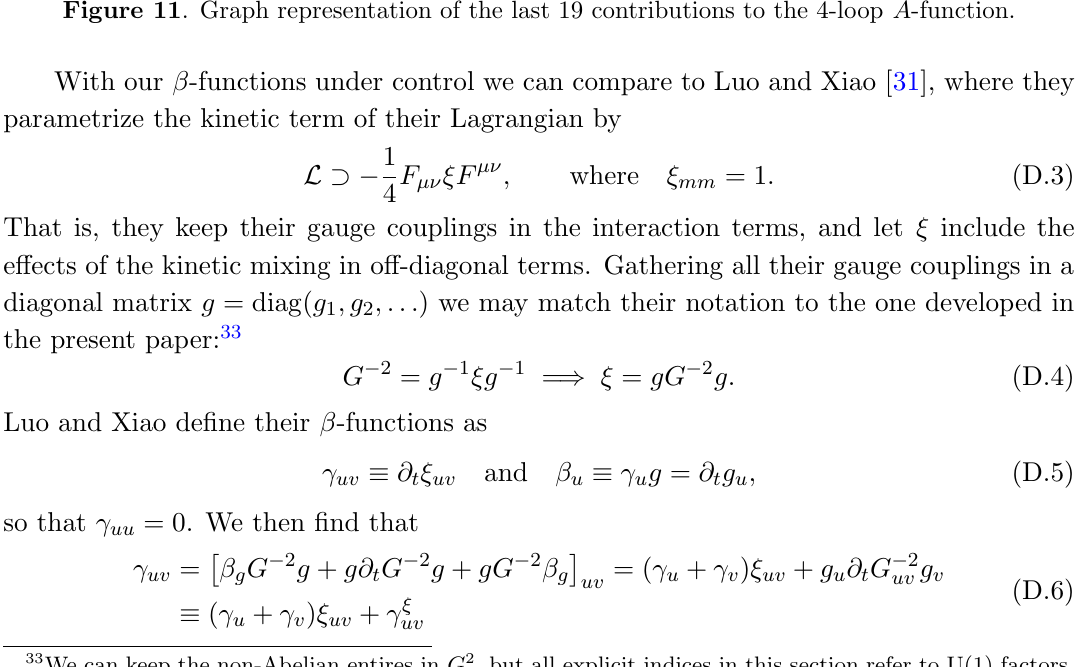
Figure 11 . Graph representation of the last 19 contributions to the 4-loop A